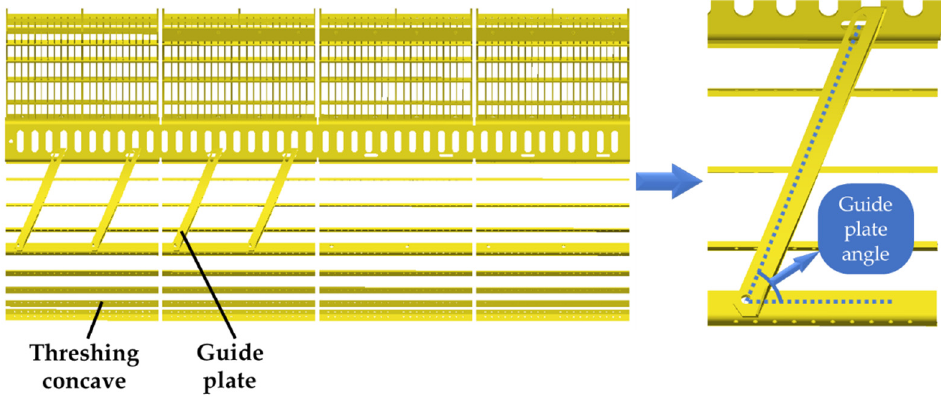
Figure 4. Structure of threshing concave plate.